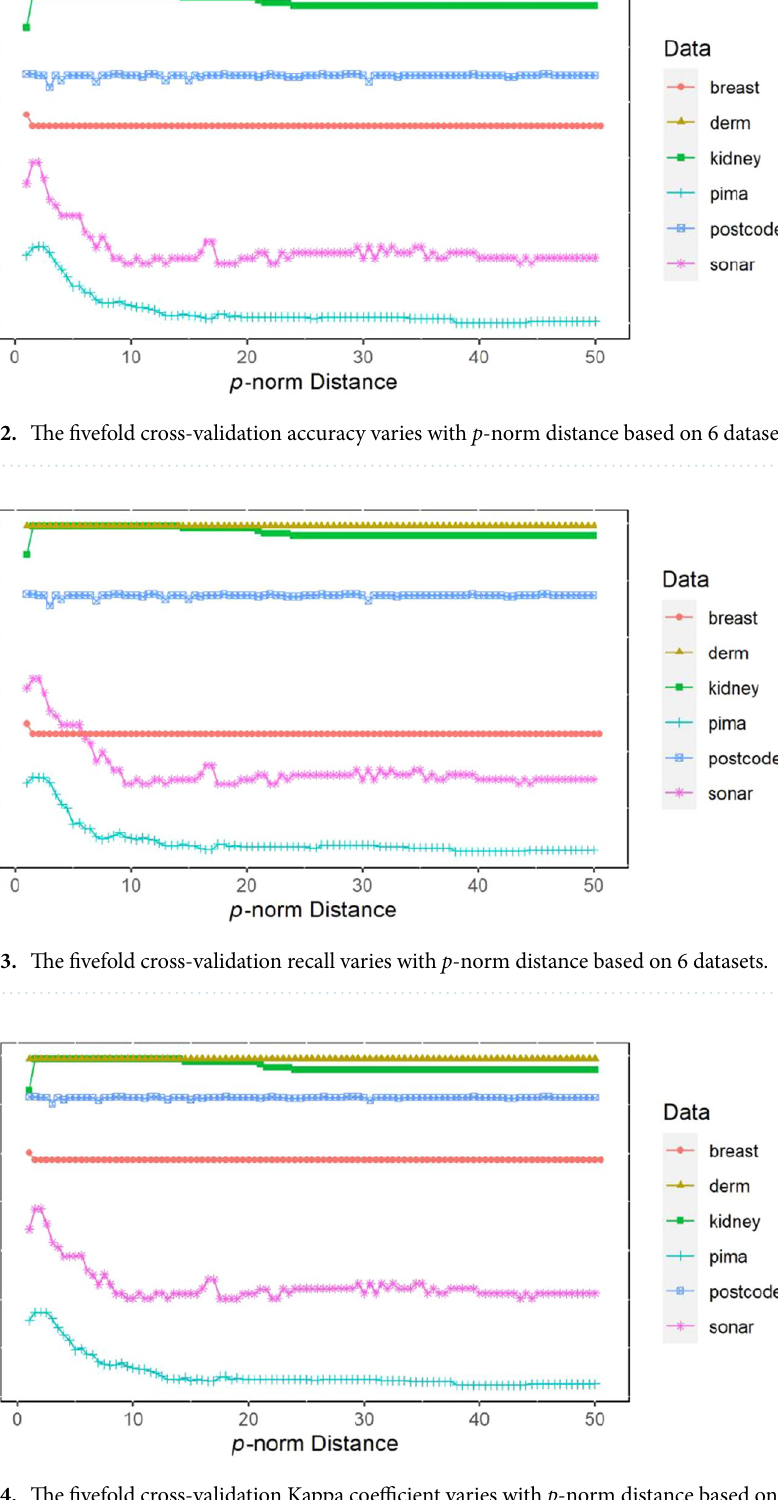
Figure 4. The fivefold cross-validation Kappa coefficient varies with p -norm distance based on 6